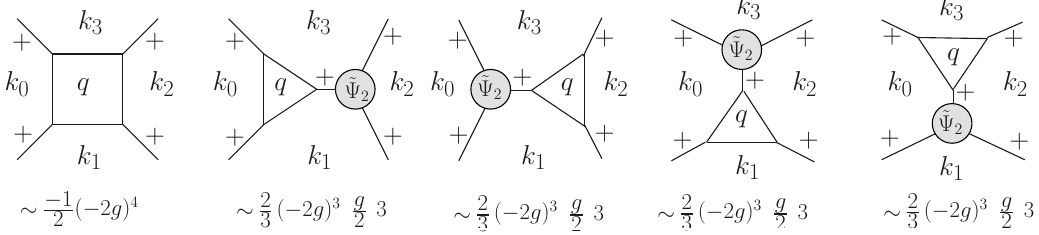
Figure 10 . The contributing terms to the all-plus (++++) helicity one-loop amplitude with explicit region momenta assignments and symmetry factors. q is the region momentum associated with the loop and k with the external region. ˜Ψ represents the inverse Wilson line kernel eq. (3.14) i 2 expanded to second